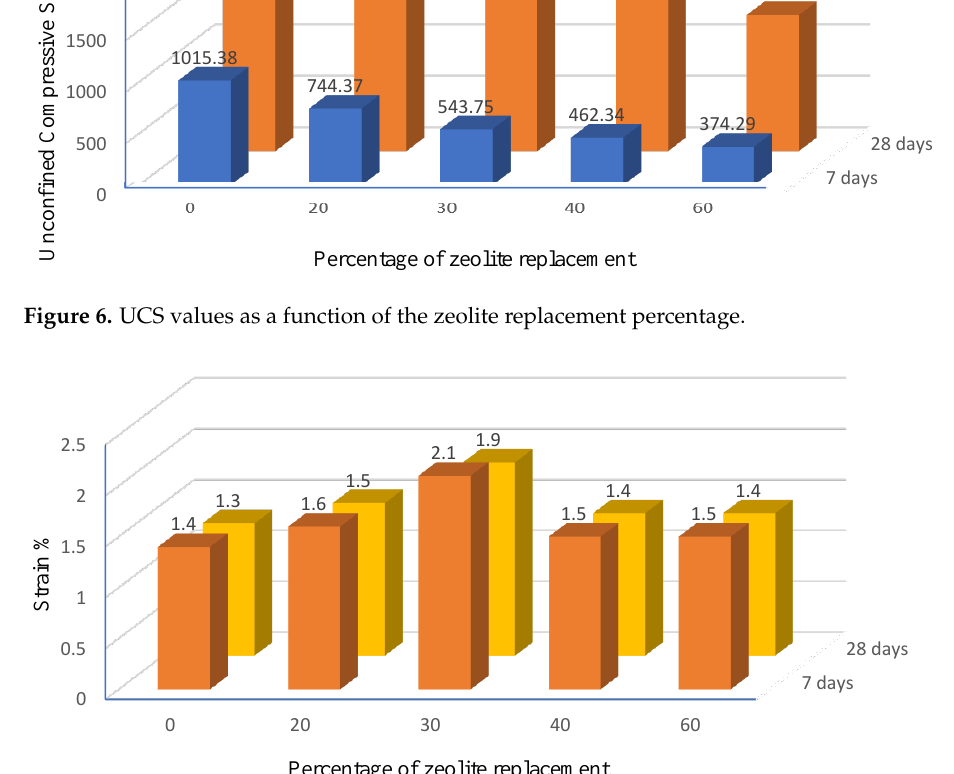
Figure 7. Values of ultimate strain against zeolite replacement percentage instead of cement. Figure 8 represents the range bars of replicates’ UCS and the variation trends of UCS in the samples for different percentages of using zeolite instead of cement for 7 and 28 days of curing, respectively.